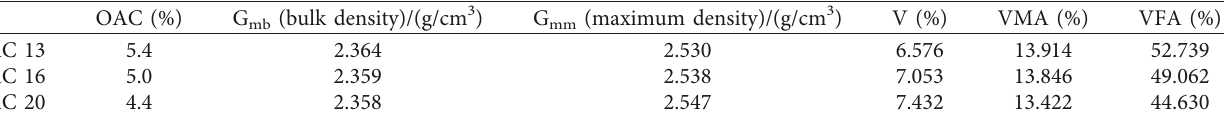
Table 4: Volumetric properties of single layer mixture